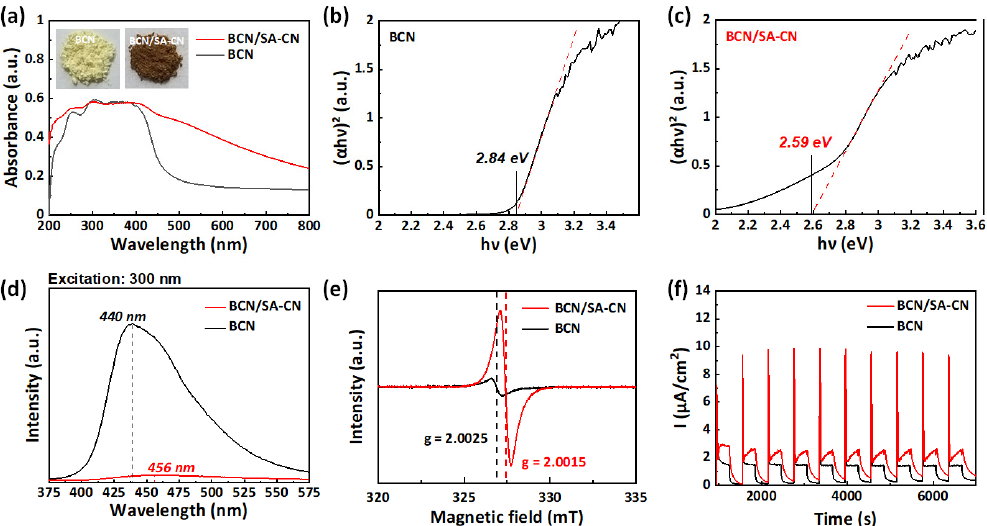
Figure 6. ( a ) UV/Vis diffuse reflectance spectroscopy (DRS) of BCN and BCN/SA-CN, Tauc-plot of ( b ) BCN and ( c ) BCN/SA-CN calculated from UV/Vis DRS by the Kubelka-Munk function, ( d ) photoluminescence (PL) emission spectroscopy, ( e ) electron spin resonance (ESR) spectroscopy and ( f ) photocurrent of BCN and BCN/SA-CN.